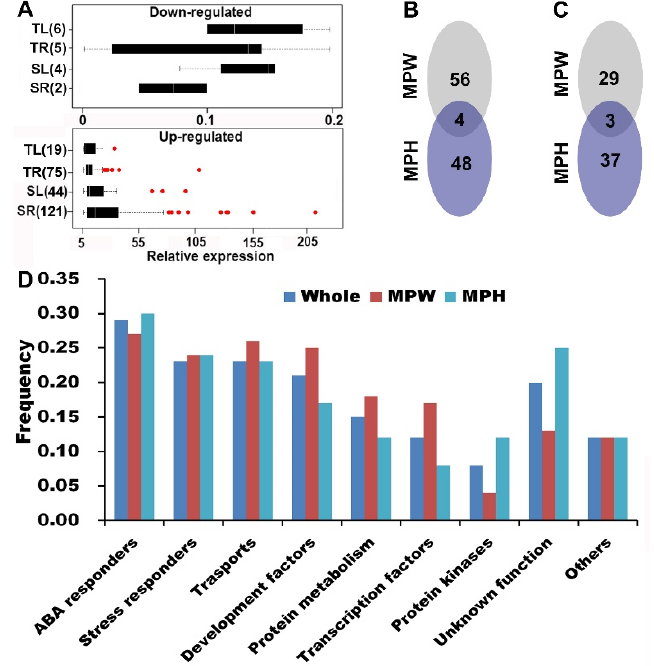
Figure 3. qRT-PCR-verified candidate genes that confer drought tolerance in the CCSP. ( A ) Boxplots, quantitative Real-time PCR (qRT-PCR) was performed after one h PEG-treatment. The Boxplots of 25, 80, 48 and 123 significantly differential-expressed genes (more than five-folds) in the leaf and root of drought tolerance accession (TL, TR) and drought sensitive accession (SL, SR). The red dots in the up-grated graph are outliers with a relative expression value of more than 1.5 times the interquartile range. ( B ) The Venn-Diagram of 108 qRT-PCR-verified genes between MPW-SC-QTL and MPH-SC-QTL. ( C ) The Venn-Diagram of 69 qRT-PCR-verified genes between MPW-LC-QTL and MPH-LC-QTL. ( D ) GO functional classification of the verified drought tolerance candidate genes.